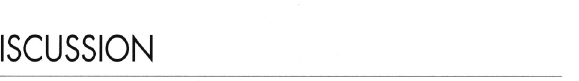
fluid or tissue), the positivity raters were as follows: 35 % (7/20) of cord blood (CB), 90 % (18/20)